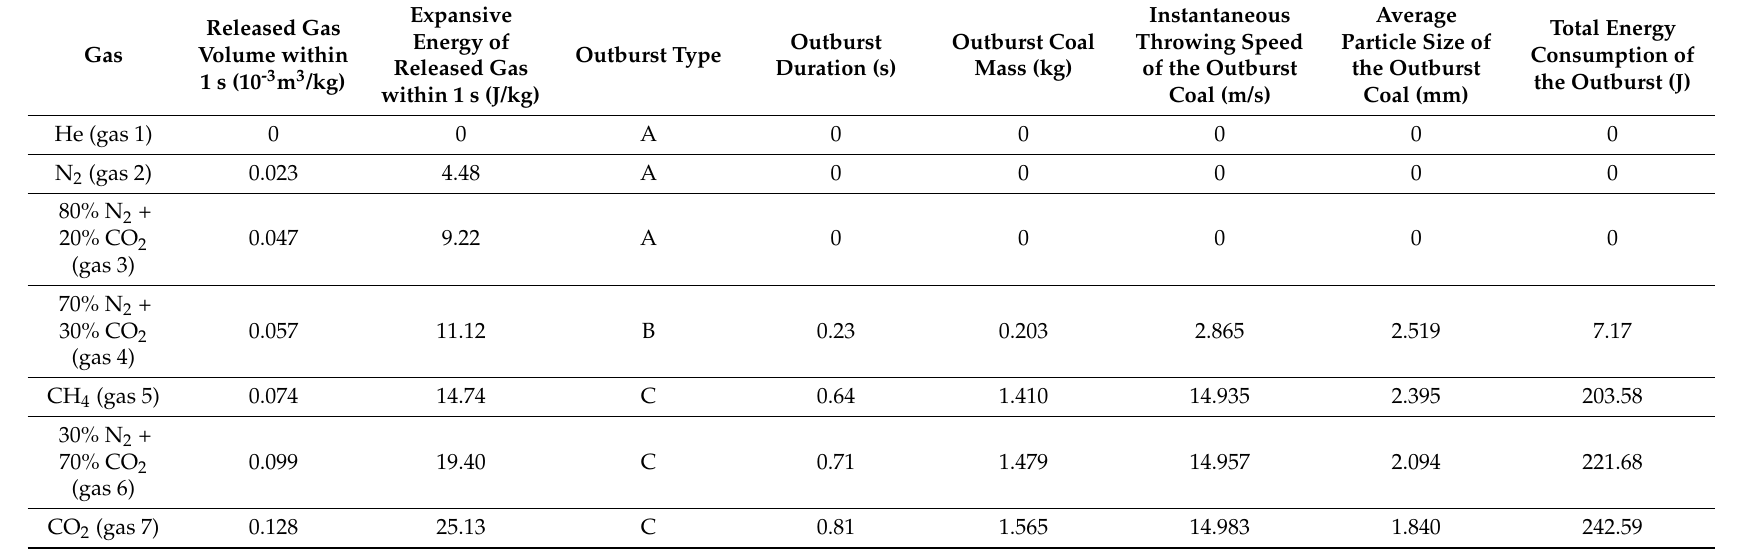
Table 1. Results of the outburst experiments and energy